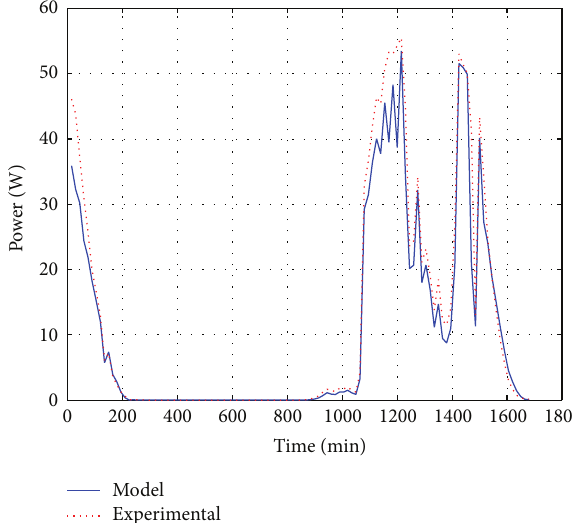
Figure 7: Comparison of the simulation results and monocrys- talline silicon panel measurement.